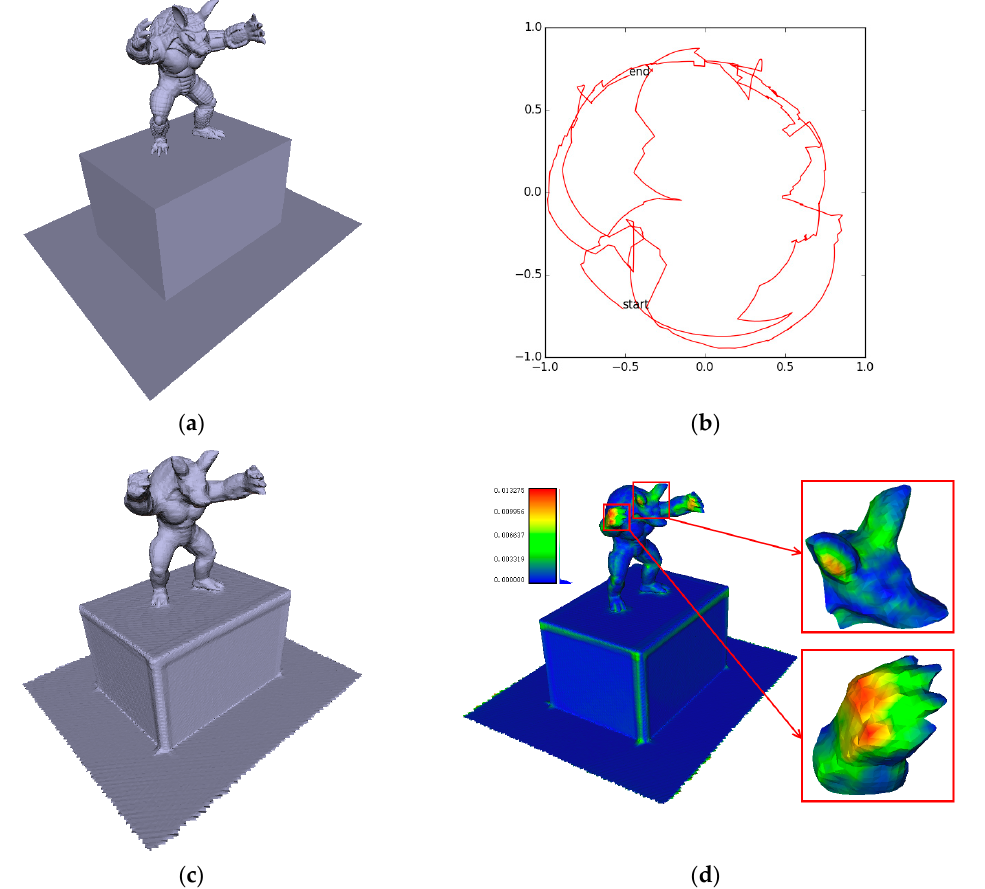
Figure 5. ( a ) Ground-truth (GT) mesh surface model and ( b ) GT camera trajectory which are used for depth image generation; ( c ) Surface reconstruction with GT camera trajectory as input using the simple moving average TSDF fusion strategy; ( d ) A heat map is used to visualize the cloud-to-mesh distances from reconstructed point cloud to the GT mesh. Note the inflation of the cuboid edges, the claws and ears of the armadillo character.